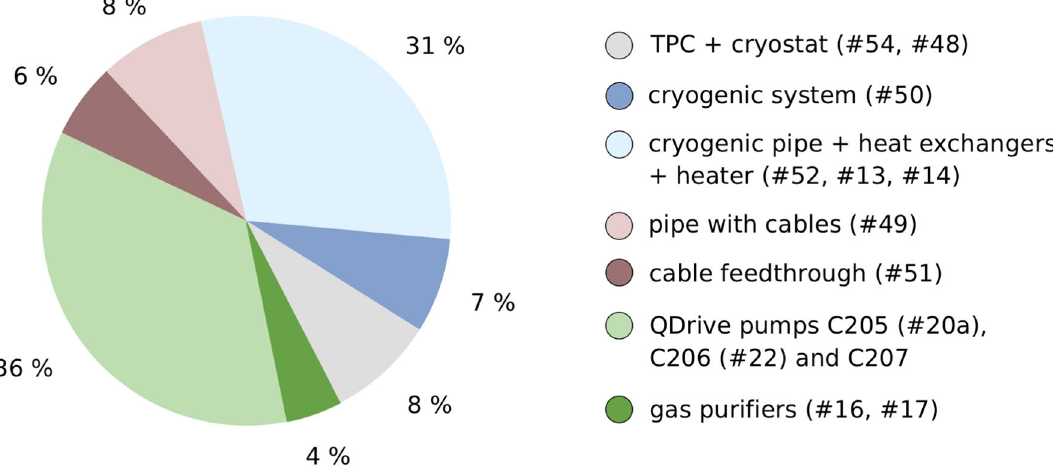
Fig. 2 The different sub-system contributions to the overall 222 Rn emanation rate in XENON1T. The colors correspond to those used in Fig. 1. The numbers in the brackets refer to the item numbers. QDrive pump C207 was not measured. Its 222 Rn emanation rate was estimated (see text)